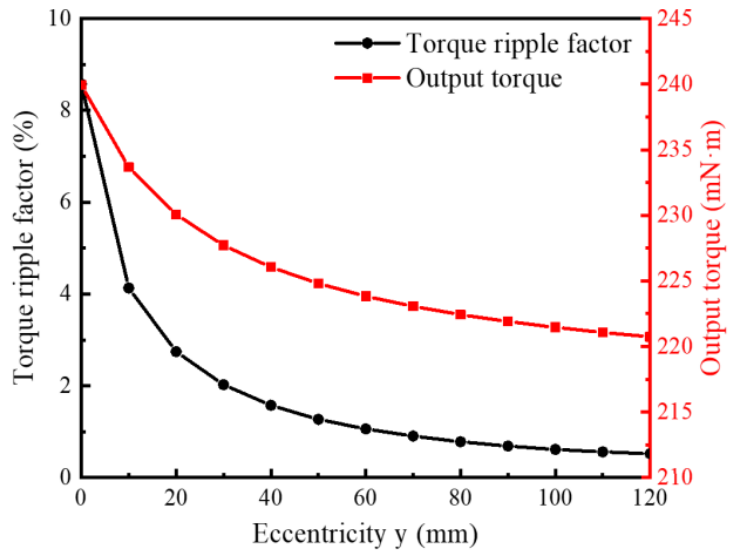
Figure 12. The relationship between eccentricity of eccentric magnetizing fixture and output torque and torque ripple coefficient.